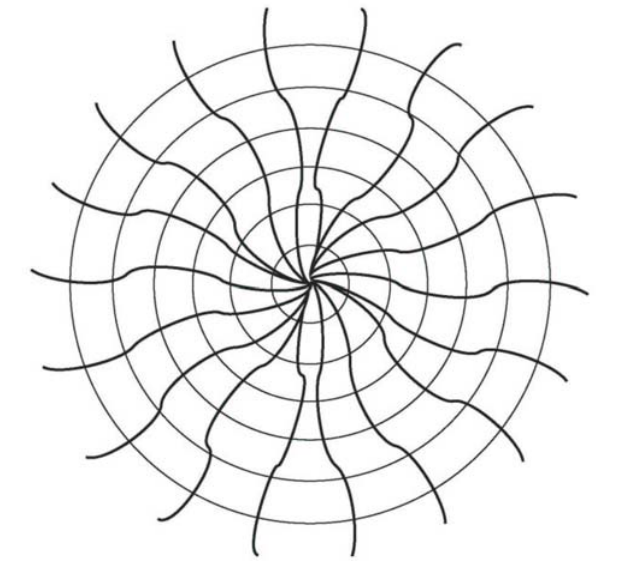
FIGURE 2. The aspects illustrated across the organizational